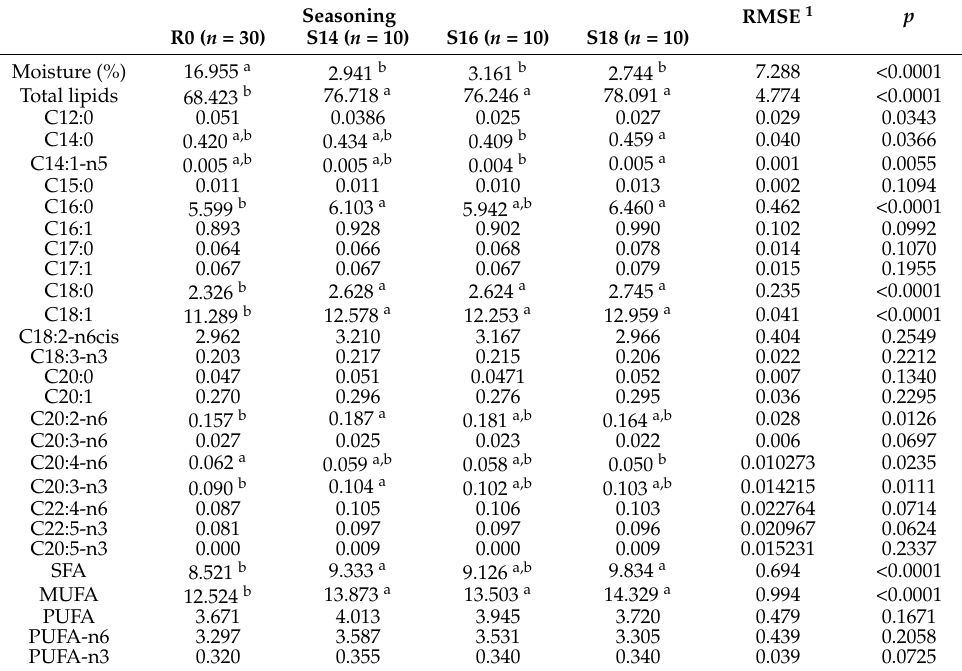
Table 2. Moisture and fatty acids profile of raw and seasoned (S14, S16, S18) subcutaneous fat of Toscano dry-cured